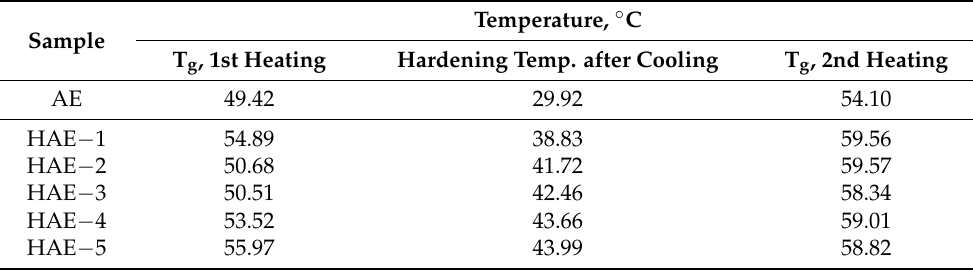
Table 4. Results of hardening temperature and glass transition temperature (T g ) of AE and HAEs at 1st and 2nd heating.